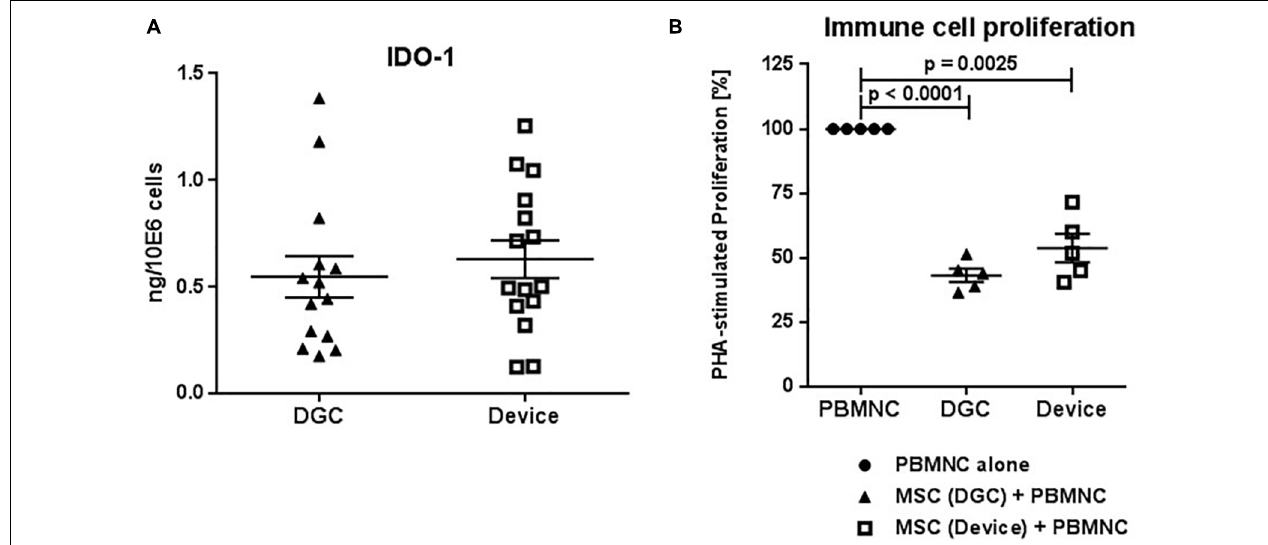
FIGURE 9 | IDO-1 production and in vitro immunomodulation capacity. Quantification of IDO-1 protein in MSC lysates at P3 (A) . Protein concentrations are calculated in nanograms per million cells. Each data point represents one biological replicate ( n = 5 donors). Error bars: SEM. Suppression of